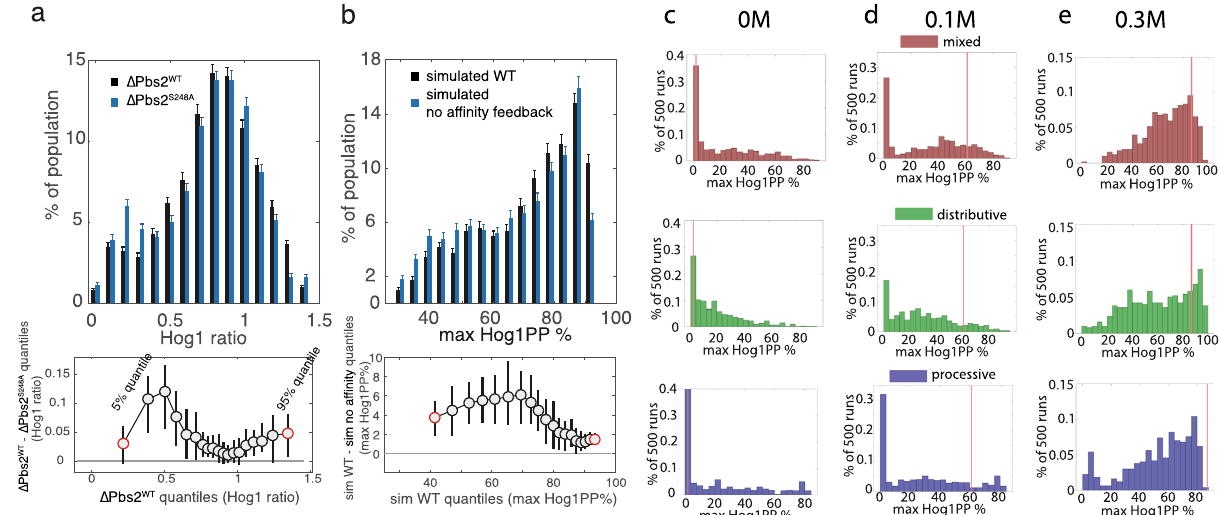
Fig. 6 | Mixed mechanism with positive feedback is more robust to protein concentration perturbations. a Histograms of the distribution of the maximal Hog1 nuclear to cytosolic ratio asa proxy forHog1 activity for Δ Pbs2 WT (black) and Δ Pbs2 S248A strains (blue). Data are presented as percent of total cell population± standard deviations computed using a bootstrap procedure. The difference in the distribution and its signi fi cance was assessed using a quantile shift function, plot- tingthedifferenceof5%to95%quantilesoftheHog1activationwithaspacingof5% against the quantile values of the Δ Pbs2 WT strain. 95% con fi dence intervals com- puted via percentile bootstrap are indicated. b Histograms of the distribution of 2000simulationsofthebest fi ttingmodelwithmixedphosphorylationmechanism with starting protein concentrations randomly varied. The maximal percentage of